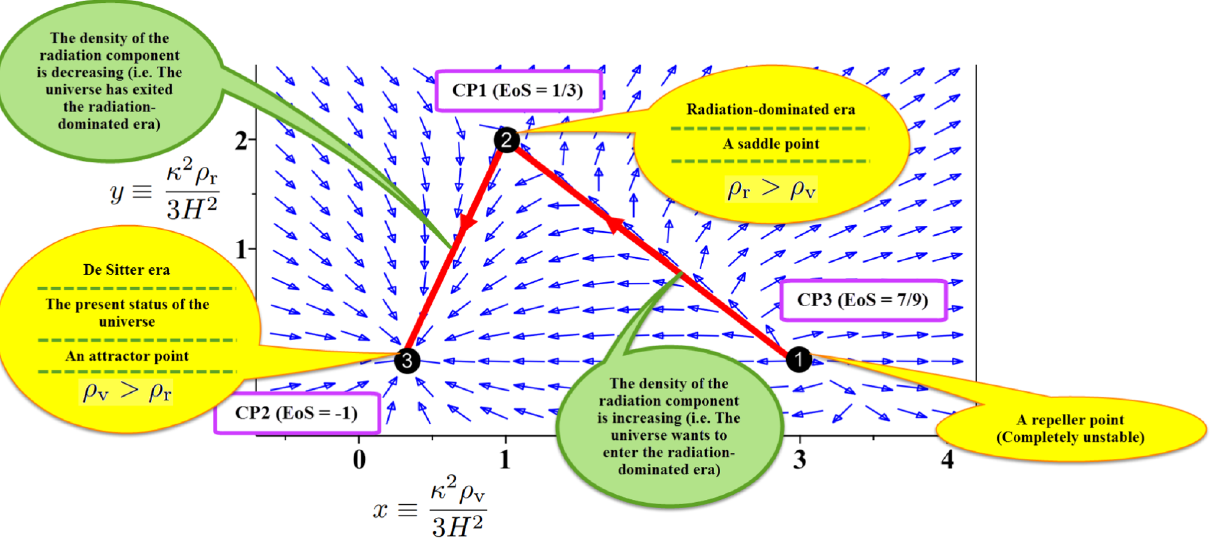
Fig. 3 This figure is an explanation of the phase-portrait of system (33)–(35) in Poincaré section x − y − 1 and w = 0 and one further EoS which cannot be eff .